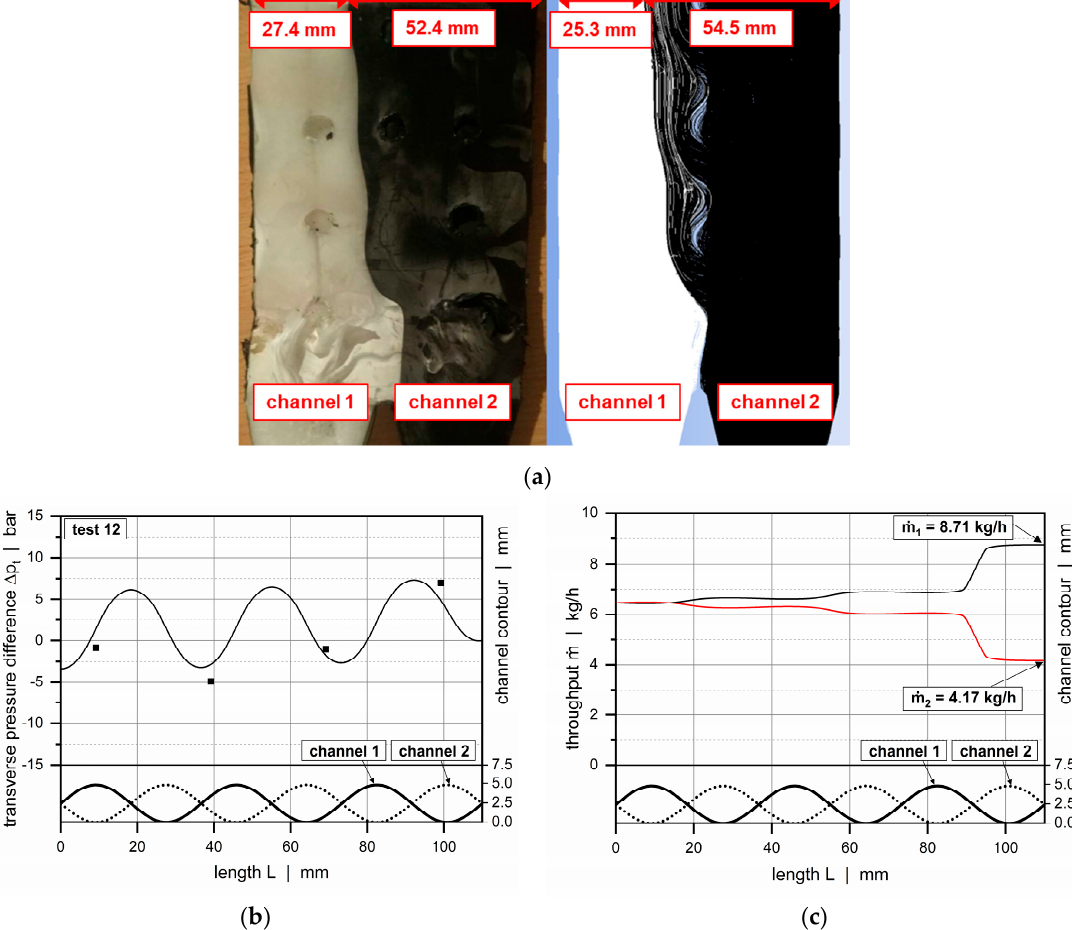
Figure 22. Comparison between experimental data and calculated solutions (seminumerical approach based on network theory vs CFD simulation). Analysis of cross-channel flow between the channels. Figure ( a ) shows a comparison of the experimental and numerically evaluated cross-channel flows. Figures ( b ) and ( c ) compare the calculated transverse pressure differences and throughputs according to our semi-numerical approach and CFD simulations.